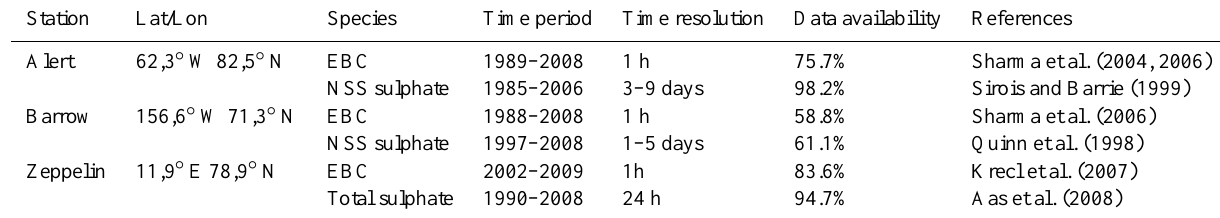
Table 1. Measurement data used in this study. Further information on the instrumentation and data can be found in the listed references.